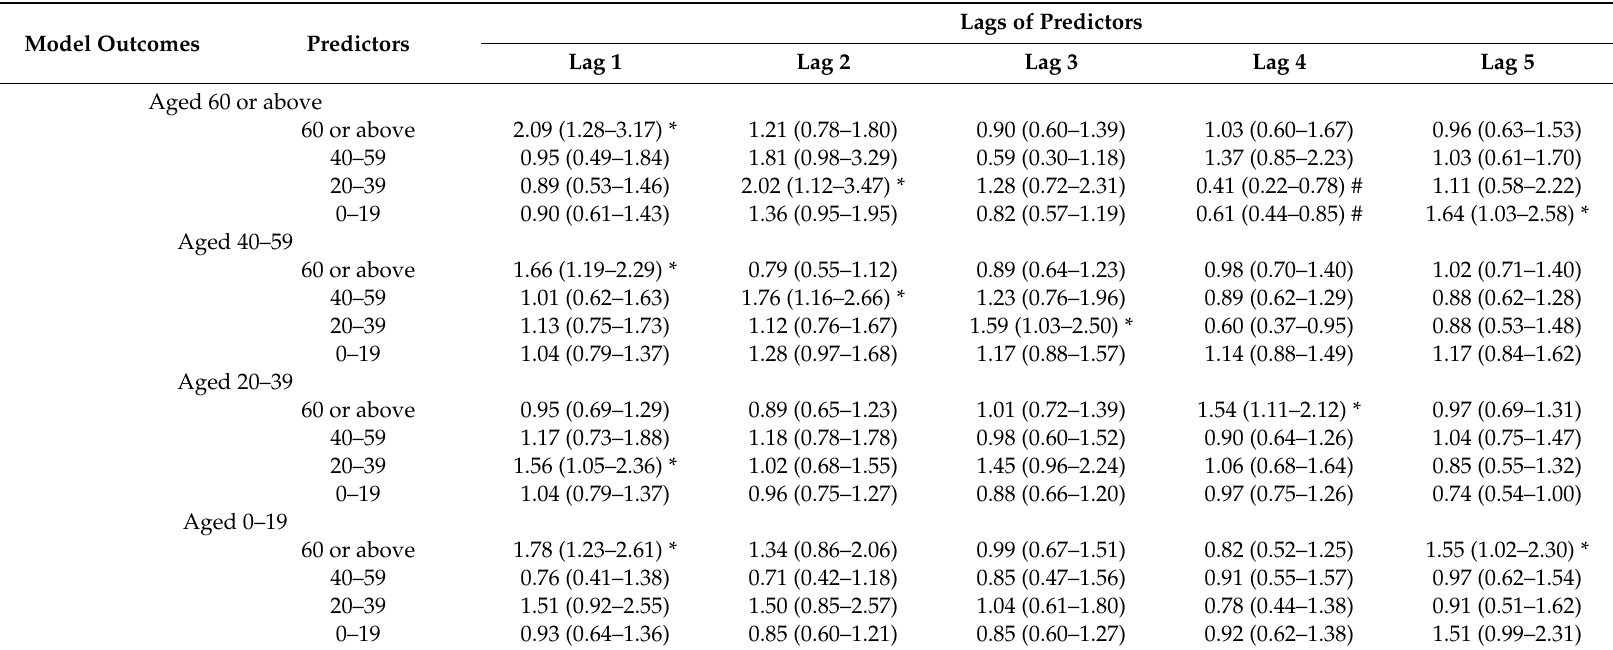
Table 1. Risk ratios in the coronavirus infection across age groups during the COVID-19 pandemic, South Korea, 10 March to 30 April 2020. Model